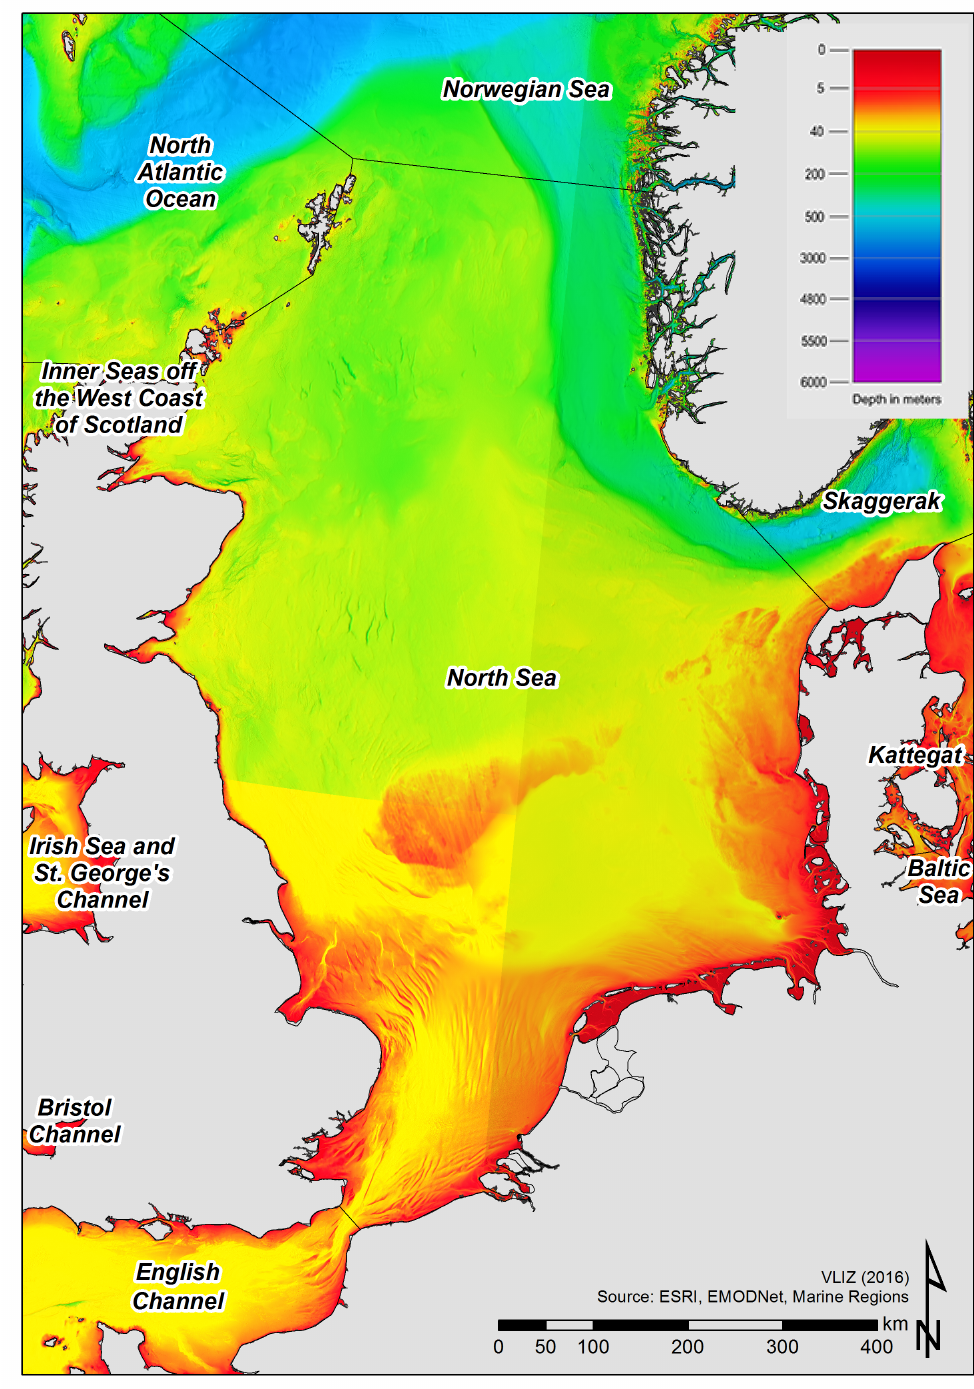
Figure 1. Bathymetry of the North Sea and adjacent seas